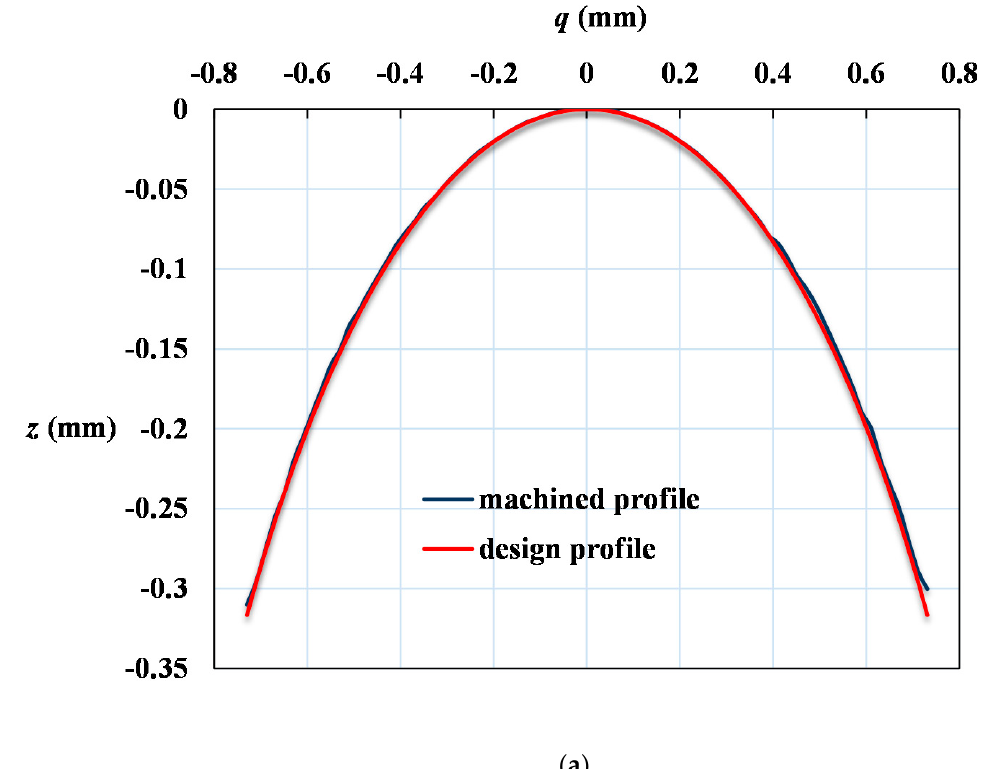
Figure 8. Cross section observed on microscope with scale grid on eyepiece. ( a ) R = 1 mm. ( b ) R = 4 mm.